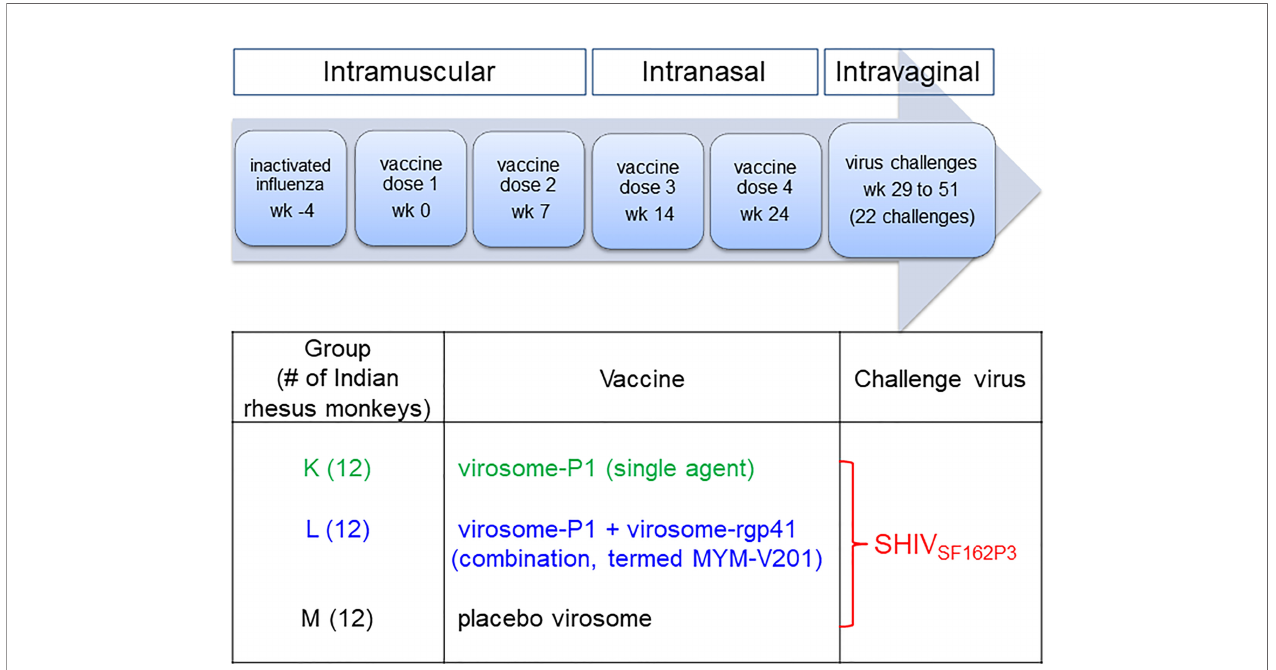
FIGURE 3 | Study design and timeline for vaccine administration and virus challenges. For three groups of 12 Indian rhesus macaques, inactivated in fl uenza virus was given intramuscularly 4 weeks (week -4) before the fi rst intramuscular vaccine dose (week 0), which was followed by the second intramuscular vaccine dose at week 7. The third and fourth vaccine doses were given intranasally at weeks 14 and 24, respectively. Intravaginal SHIV SF162P3 virus challenges were performed from week 29 to week 51. The challenges were stopped after a given animal became persistently viremic (>10,000 copies/ml) or after 22 challenges. During the vaccination phase, the study was performed blinded. For Groups K and L, blinding was maintained throughout the entire study; Group M animals were recognized as controls after immunogenicity analyses for anti-P1 peptide antibody reactivity prior to starting the SHIV SF162P3